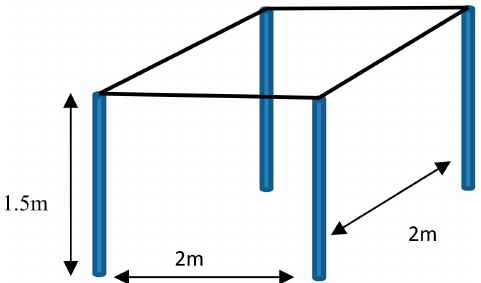
Figure 1. A grounding grid of 2 m × 2 m for the tests at different